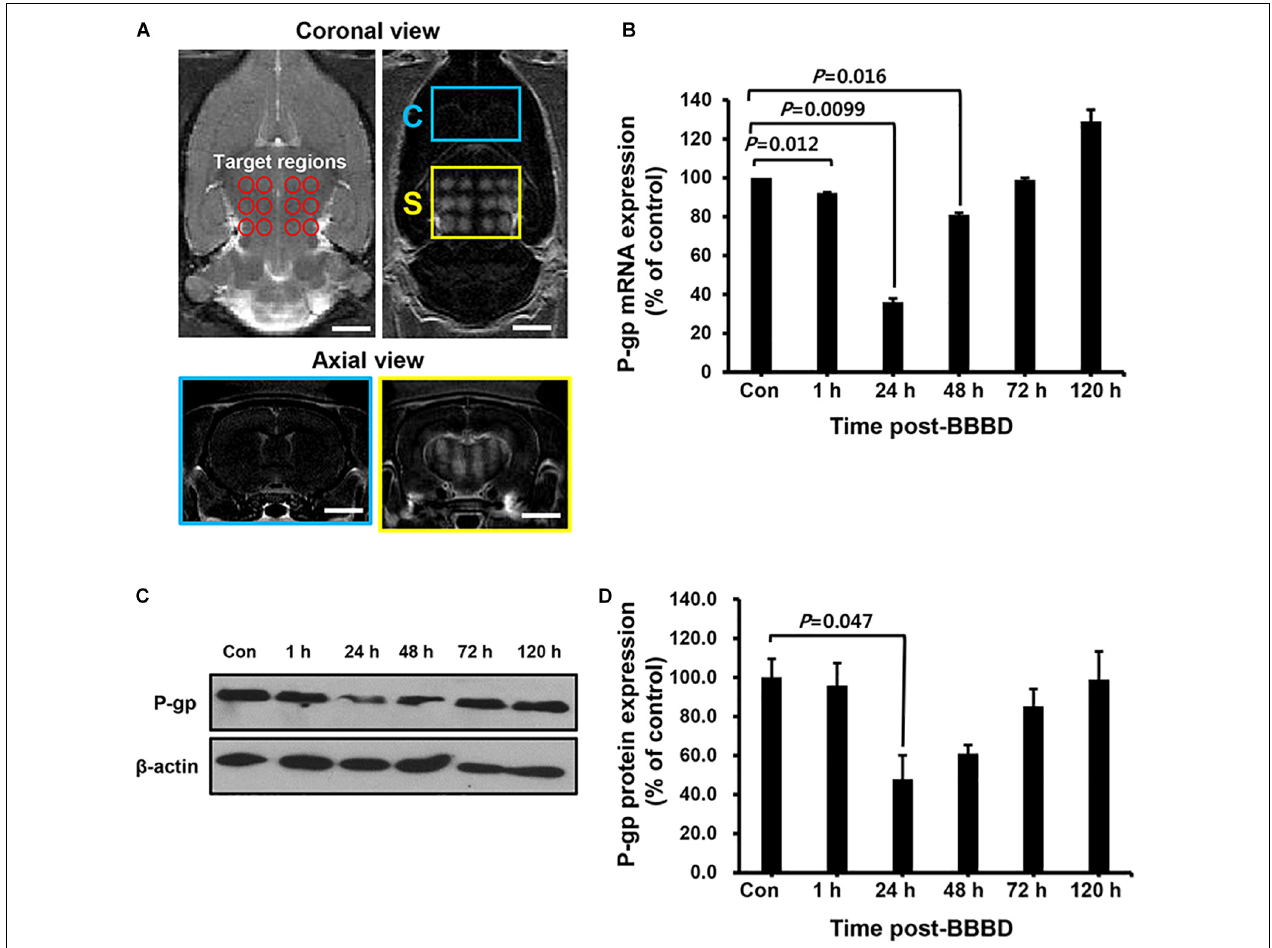
FIGURE 2 | The expression level of P-gp after BBBD by MRgFUS in a time-dependent manner. (A) The coronal view of the targeted region (top, left panel) and BBB disrupted region (top, right panel) in T2- and T1-weighted images, respectively. The axial views of the brain indicated Gd-DTPA distribution in correspondence with coronal views of the control region (bottom, blue box) and BBBD region (bottom, yellow box) after BBBD. (B) Relative P-gp mRNA expression was measured by qRT-PCR. The bar graph represented the percentage of P-gp expression level, and calculated by normalizing with control and using beta-actin as internal control gene. (C) Immunoblot was performed for P-gp and beta-actin from cerebral blood vessel after BBBD in a time-dependent manner. (D) The protein levels from Immunoblot were calculated by densitometric analysis and normalized with beta-actin. Results were presented as the mean ± SEM ( n =